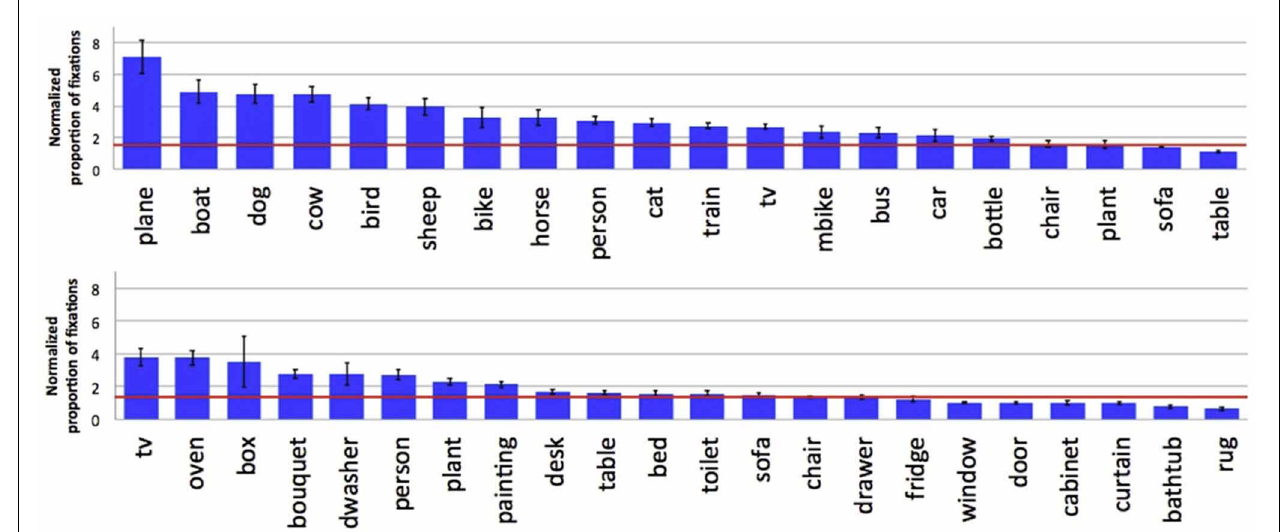
the same number of fixations, but for a different scene. The red lines indicate theaverageoftheseby-subjectbaselines.Bydoingthis,factorssuchascentral fixation biases and individual scanning strategies are partially